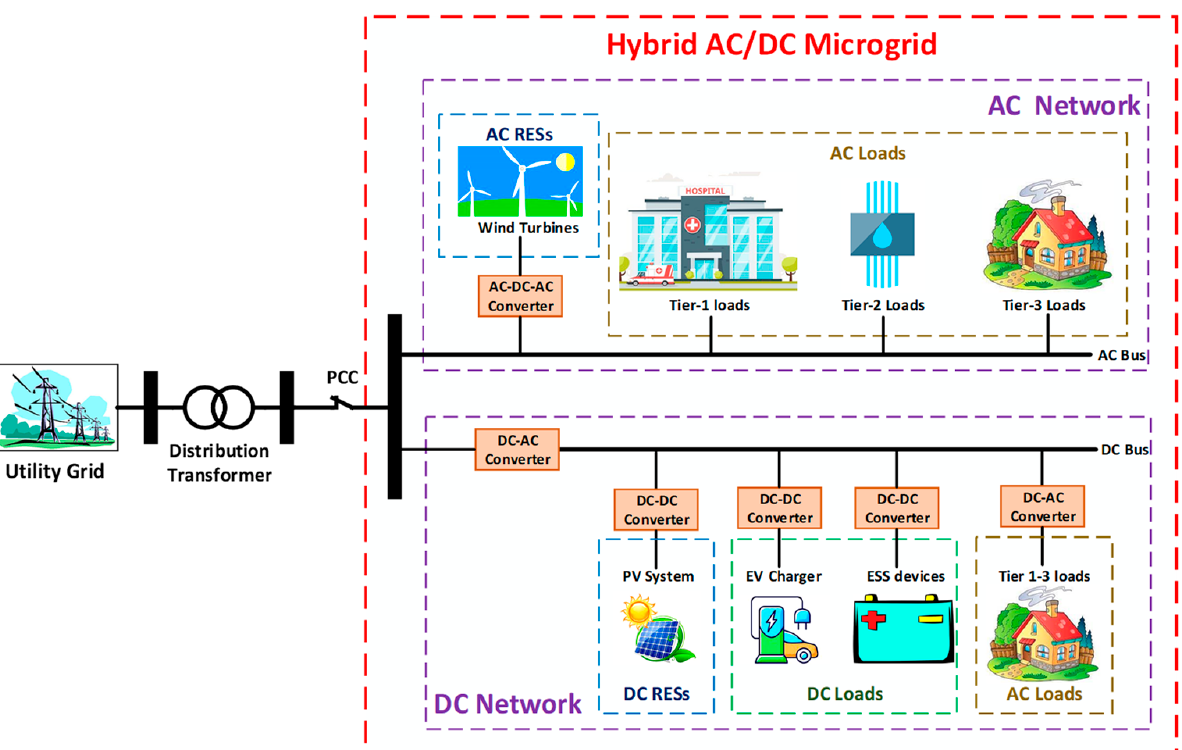
Figure 3. Simple diagram of a typical HMG.